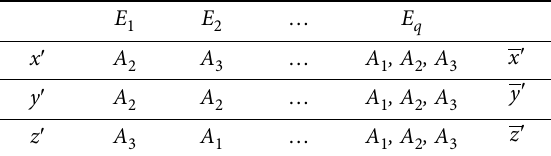
Table 3. The expert evaluations matrix